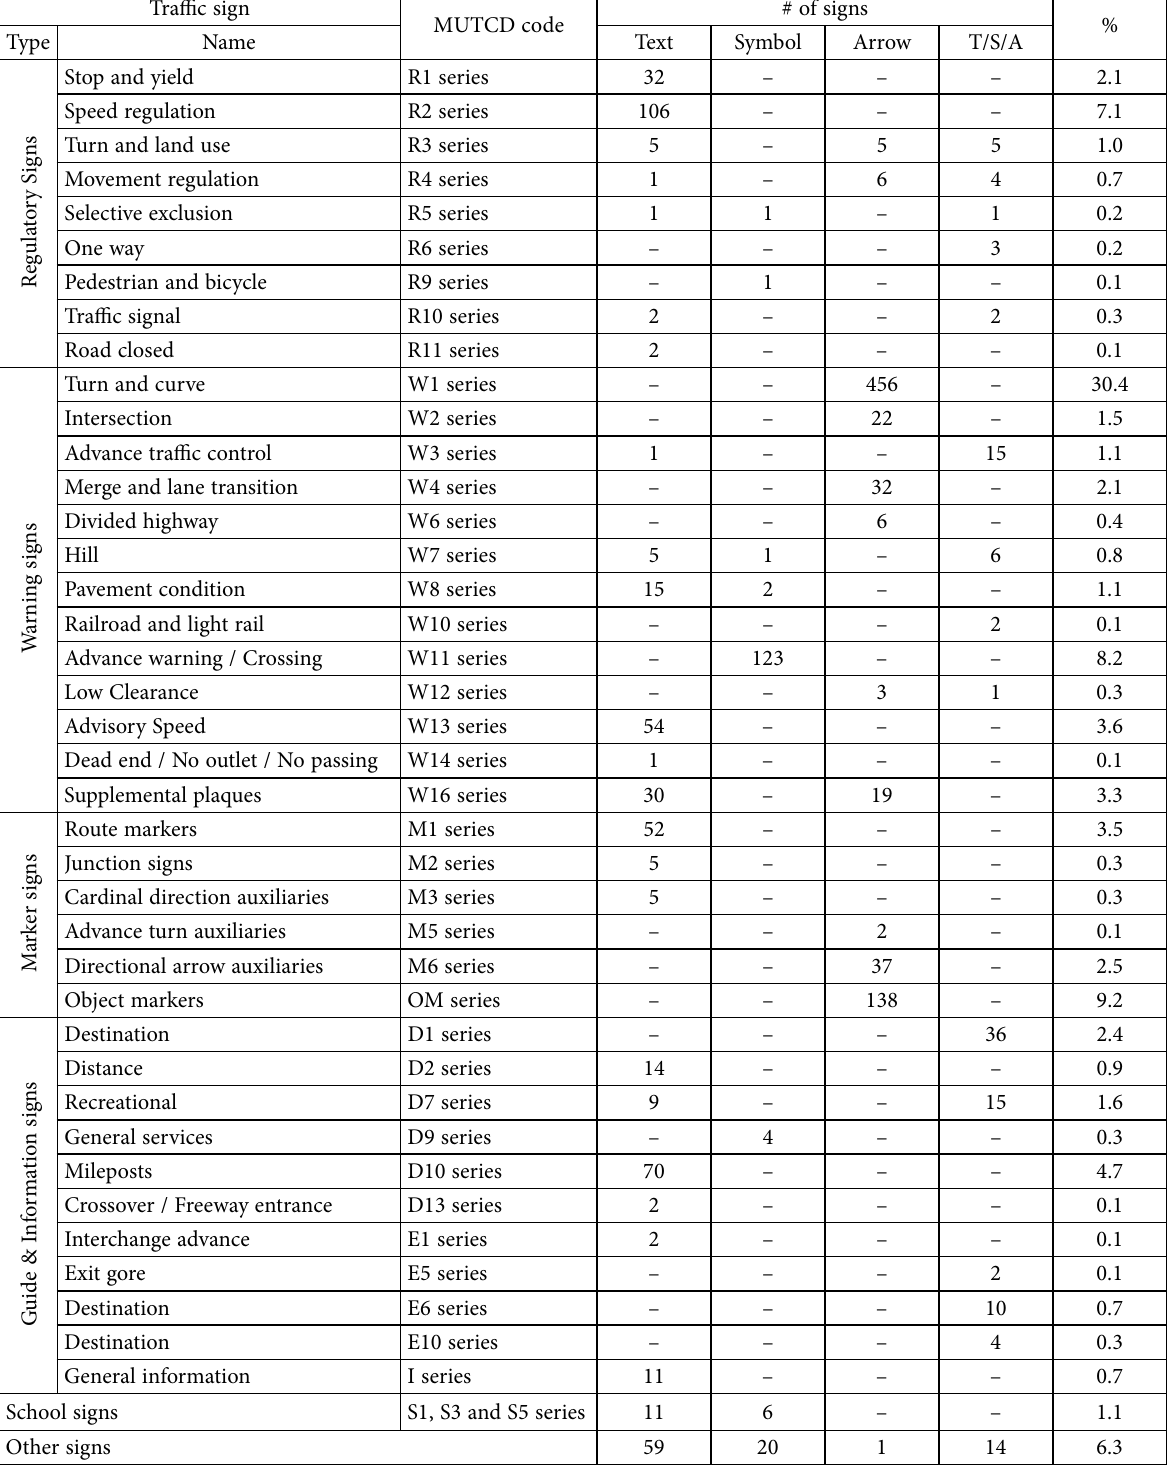
Table 1. Summary of vandalized signs by MUTCD